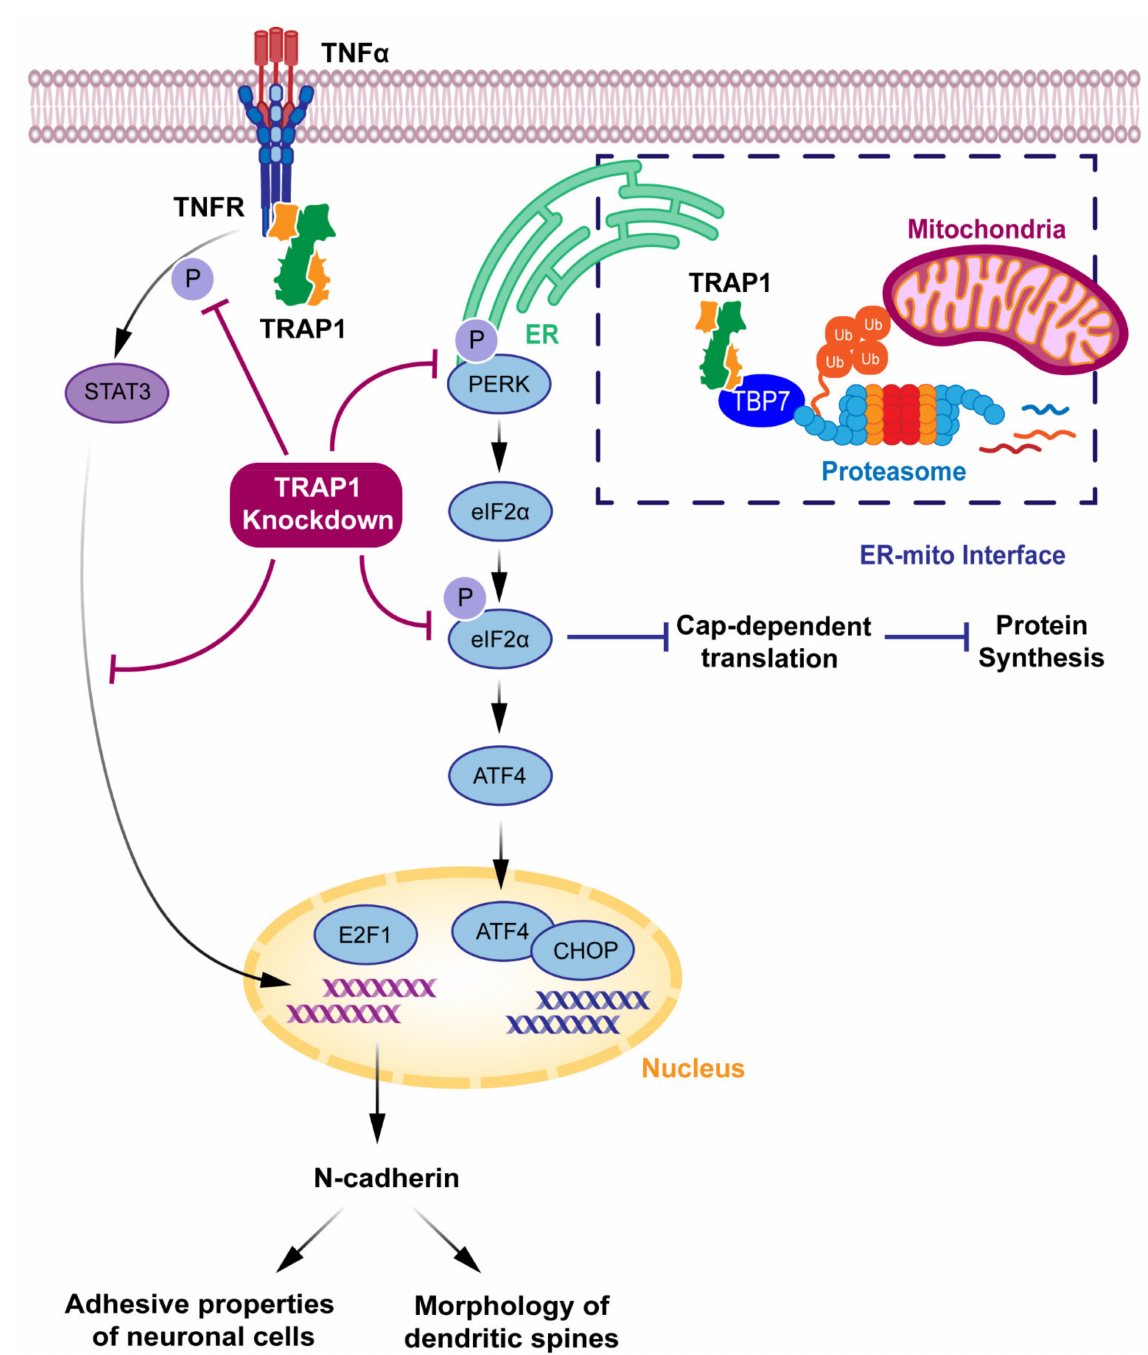
Figure 4. TRAP1 suggested extra-mitochondrial roles and proposed mechanisms. In endoplasmic reticulum (ER)- mitochondria interface, TRAP1 is associated with tat-binding protein 7 (TBP7), controlling ubiquitination and mitochondrial protein folding. In cytoplasm, TRAP1 binds to intracellular domain of tumor necrosis factor receptor-1 (TNFR1), thus interacting with tumor necrosis factor- α (TNF- α )/TNFR1 pathway. TNFR1 phosphorylates signal transducer and activator of transcription 3 (STAT3) that activates transcription factor E2F1. TRAP1 knockdown decreases phosphorylation of STAT3, which results in reduction of E2F1 and a downregulation of N-cadherin, responsible for adhesive and morphological prop- erties of neuronal cells. Activation of selective stress-responsive protein RNA-like ER kinase (PERK), and phosphorylation of translation factor eukaryotic initiation factor-2 α (eIF2 α ) block cap-dependent translation, thus reducing global protein synthesis in cell. TRAP1 knockdown decreases PERK and eIF2 α phosphorylation, and expression of C/EBP homologous protein